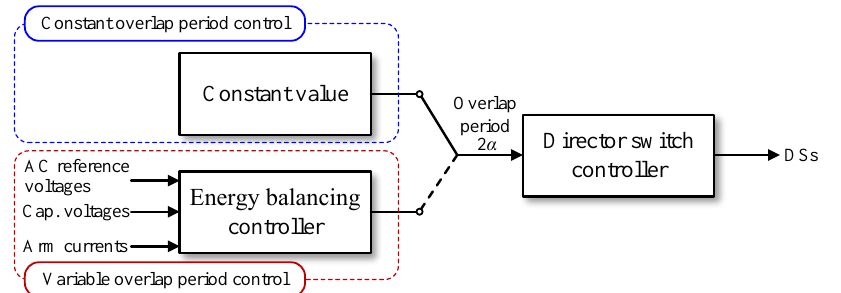
Figure 7. Implementation of overlap period control in an AAC